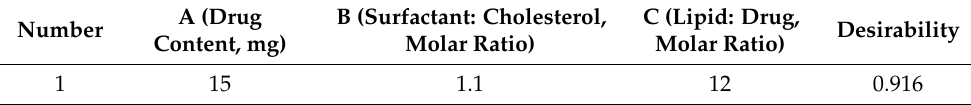
Table 7. Optimized criteria and prospective values for the variables.